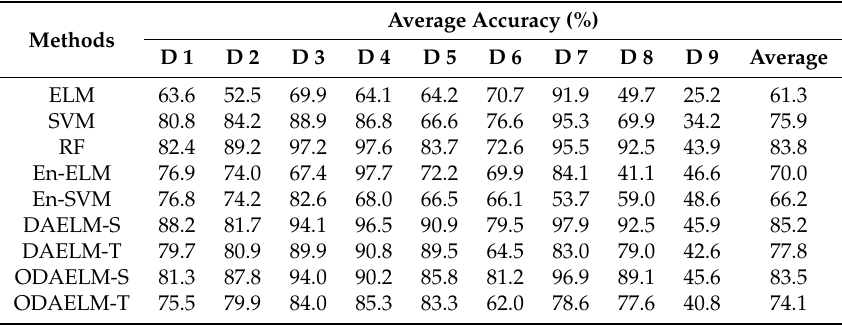
Figure 8. Processing time of DAELM-S, DAELM-T, ODAELM-S and ODAELM-T. The four methods are colored as the legend shows. ( a ) demonstrates the overall processing time for all nine target domains. Because DAELM-T is more time-consuming than the others; ( b ) is presented to help observe the differences of the other three methods. Table 2. Comparisons of average accuracies using setting